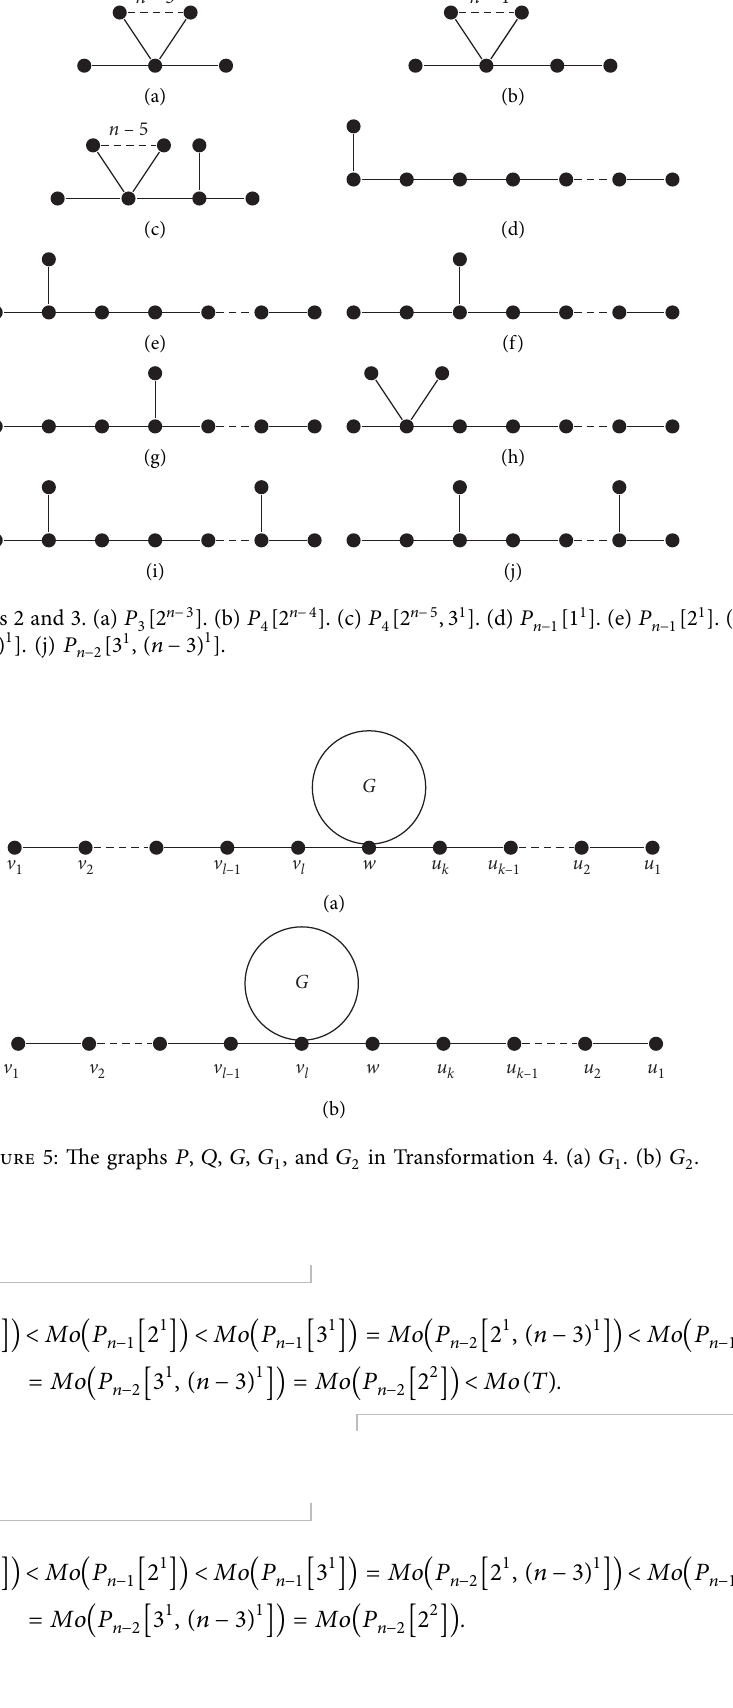
Figure 4: The trees in Theorems 2 and 3. (a) P